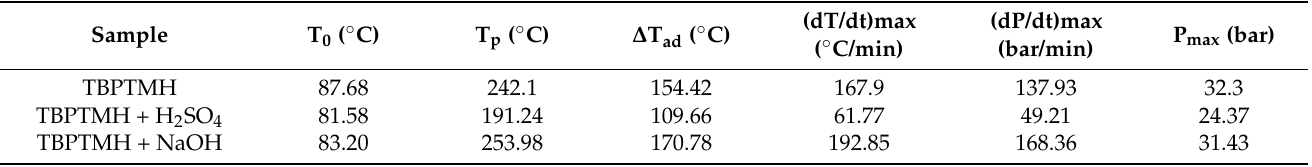
Table 4. Thermal decomposition characteristic parameters of